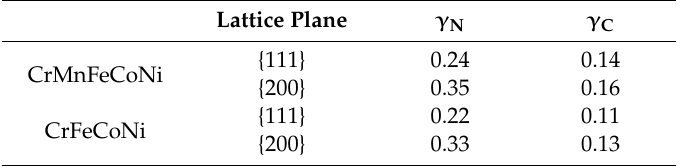
Table 5. Lattice expansion determined for CrMnFeCoNi and CrFeCoNi depending on the lattice plane and the solved interstitial element (in Å).